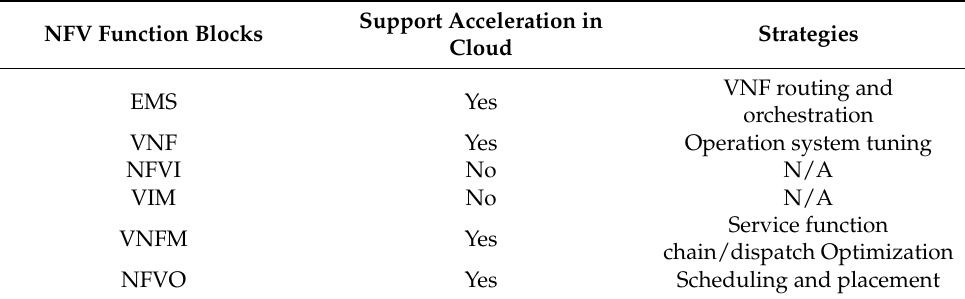
Table 8. An ETSI framework perspective on acceleration strategies that can be used in cloud